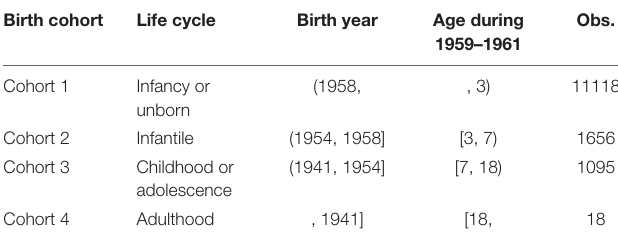
TABLE 1 | Classification of the birth